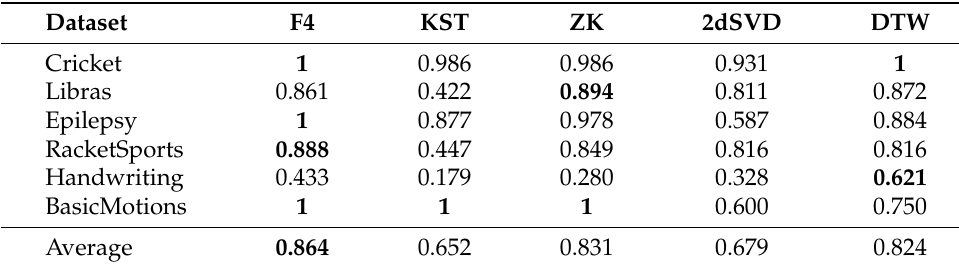
Table 9. Accuracies of the five classifiers in the six datasets from the UEA multivariate time series classification